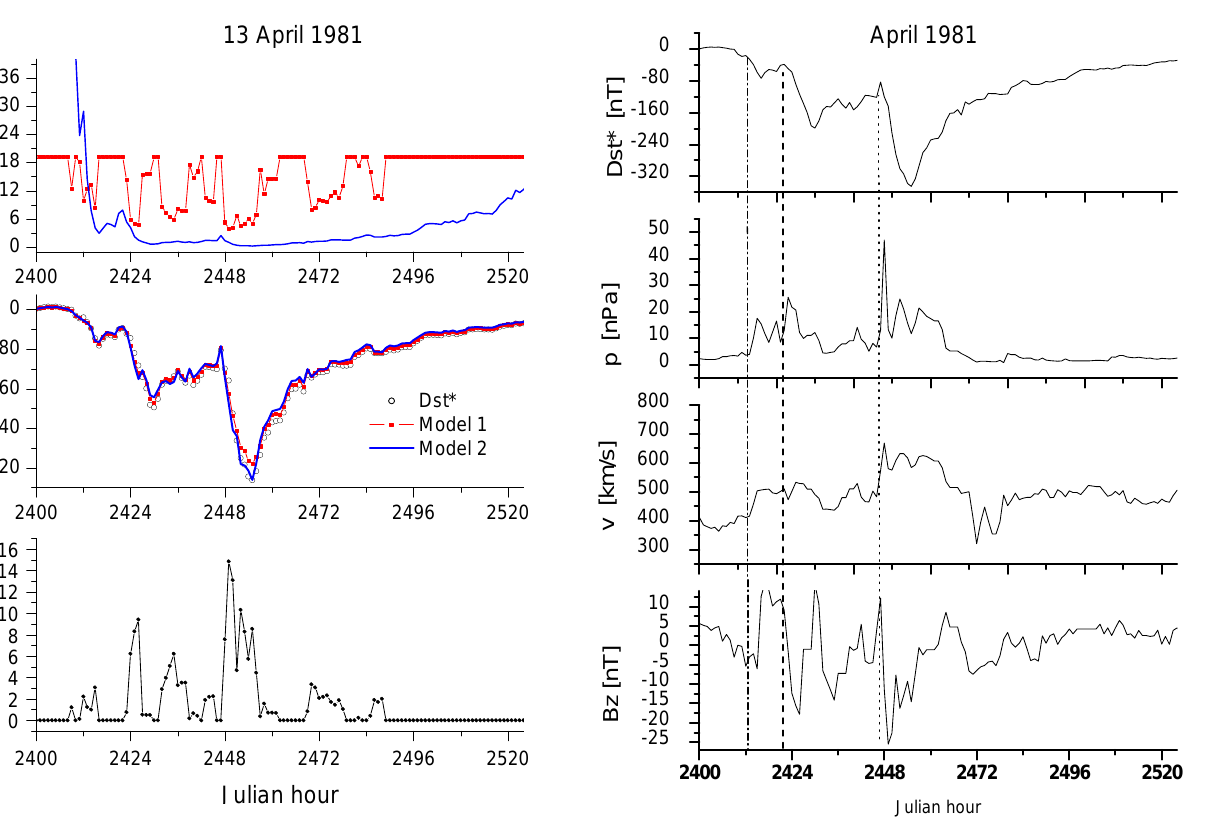
Fig. 3. The top panel shows time variability of the pressure cor- rected D st behavior during the event of 11–15 April 1981. The sec- ond panel shows time variations of the calculated dynamic pressure for the same event. The third panel shows the time variations of the solar wind velocity. The bottom panel shows the time variability of the IMF- B z